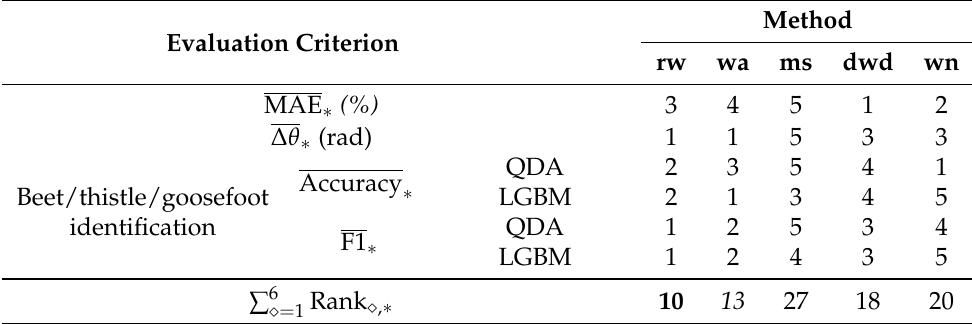
Table 5. The ranking of reflectance estimation methods for crop/weed identification. Bold shows best result and italics second best